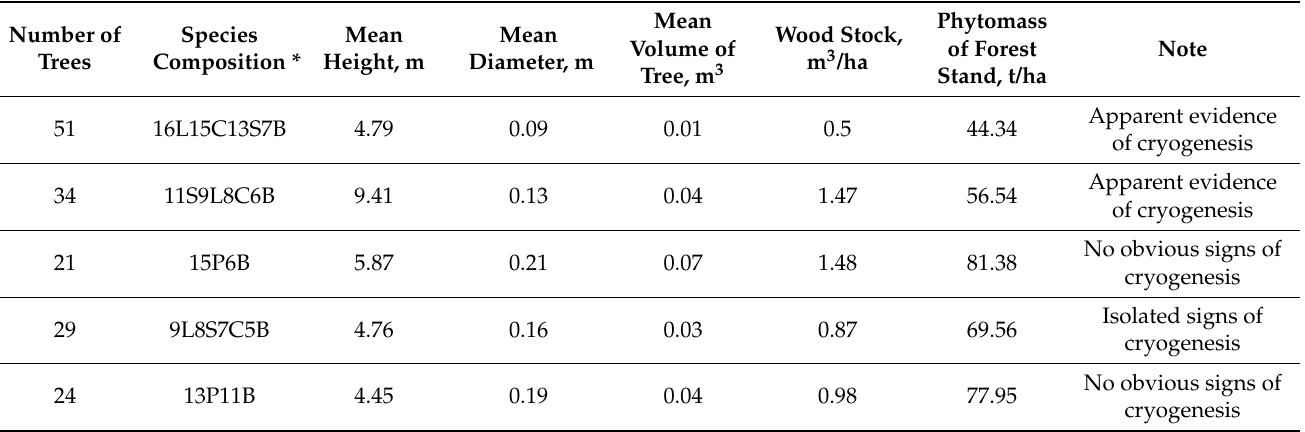
Parameters used for calculation of forest stand phytomass stocks in different geocryological